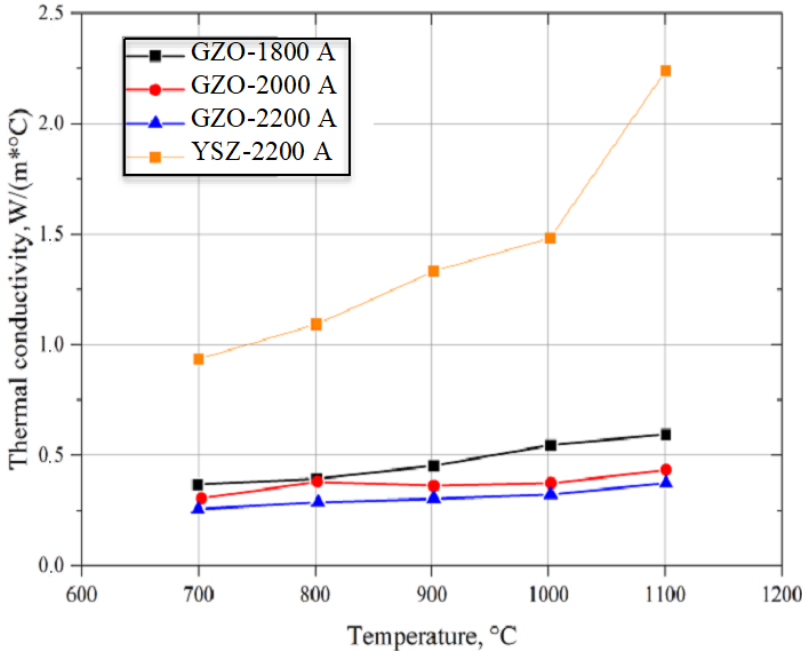
Figure 6. Thermal conductivity for YSZ-2200A and for Gd 2 Zr 2 O 7 (GZO-1800A, -2000A, and -2200A) layers produced using different power current values.